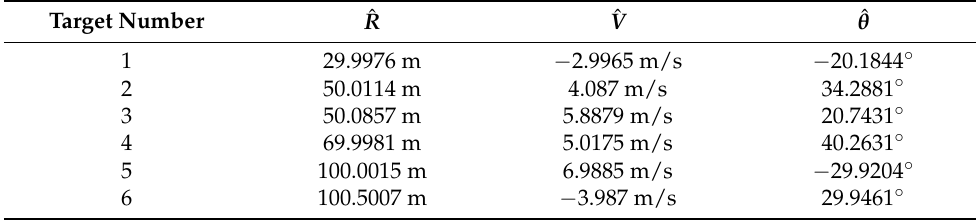
Table 1. The estimated results of the first